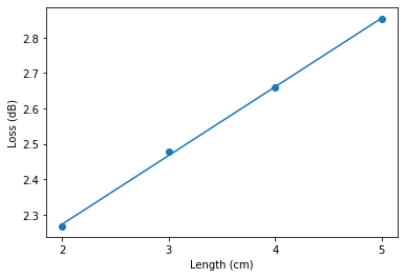
Fig 3. Optical power loss of the PMMA filament.